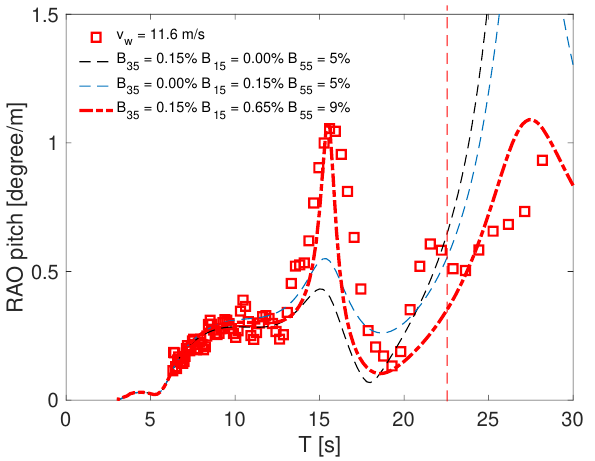
Figure 17. Numerical damping adjustment based on the test data and the wind turbine response